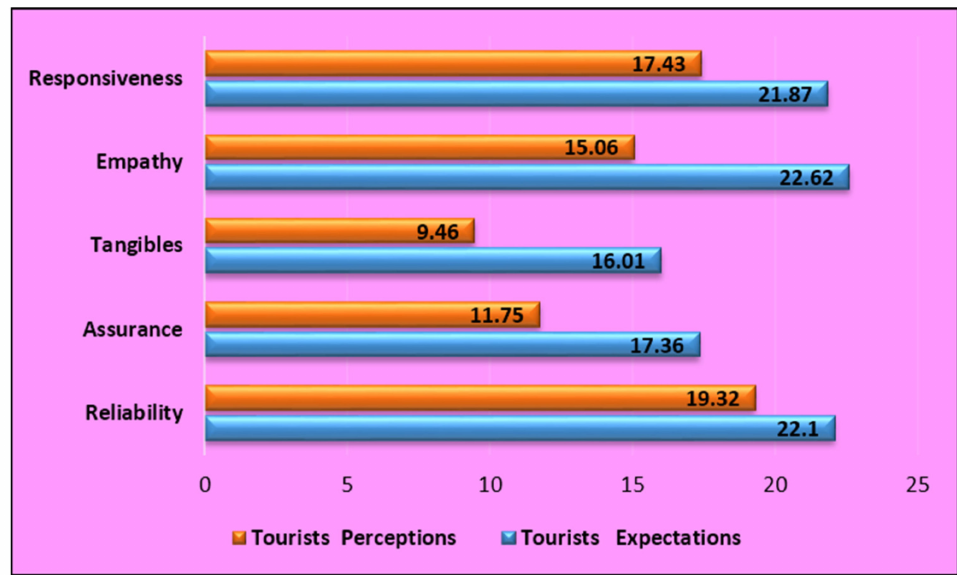
Figure 4. Expectations and perceptions of tourists about IoT as sustainable energy management solutions at tourism destinations (pictures 1–5 showing mean scores for Reliability, Assurance, Tangibles, Empathy, and